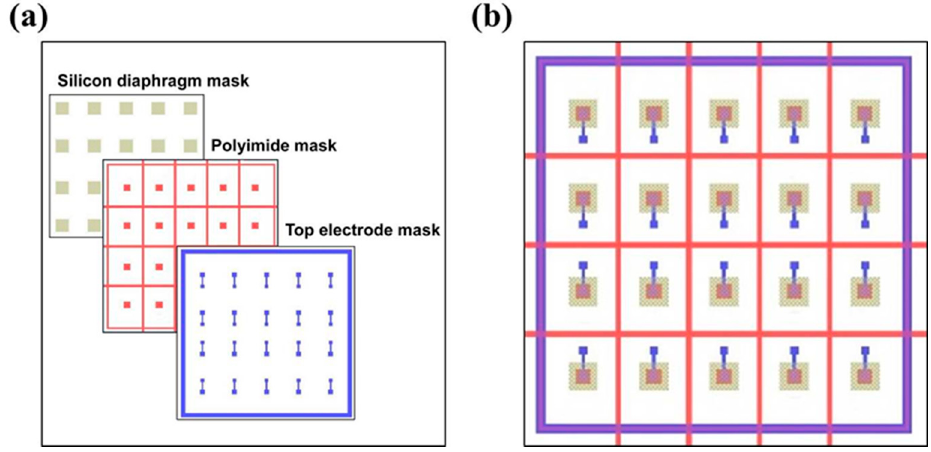
Figure 11. ( a ) Three masks for the fabrication process; and ( b ) their alignment image.